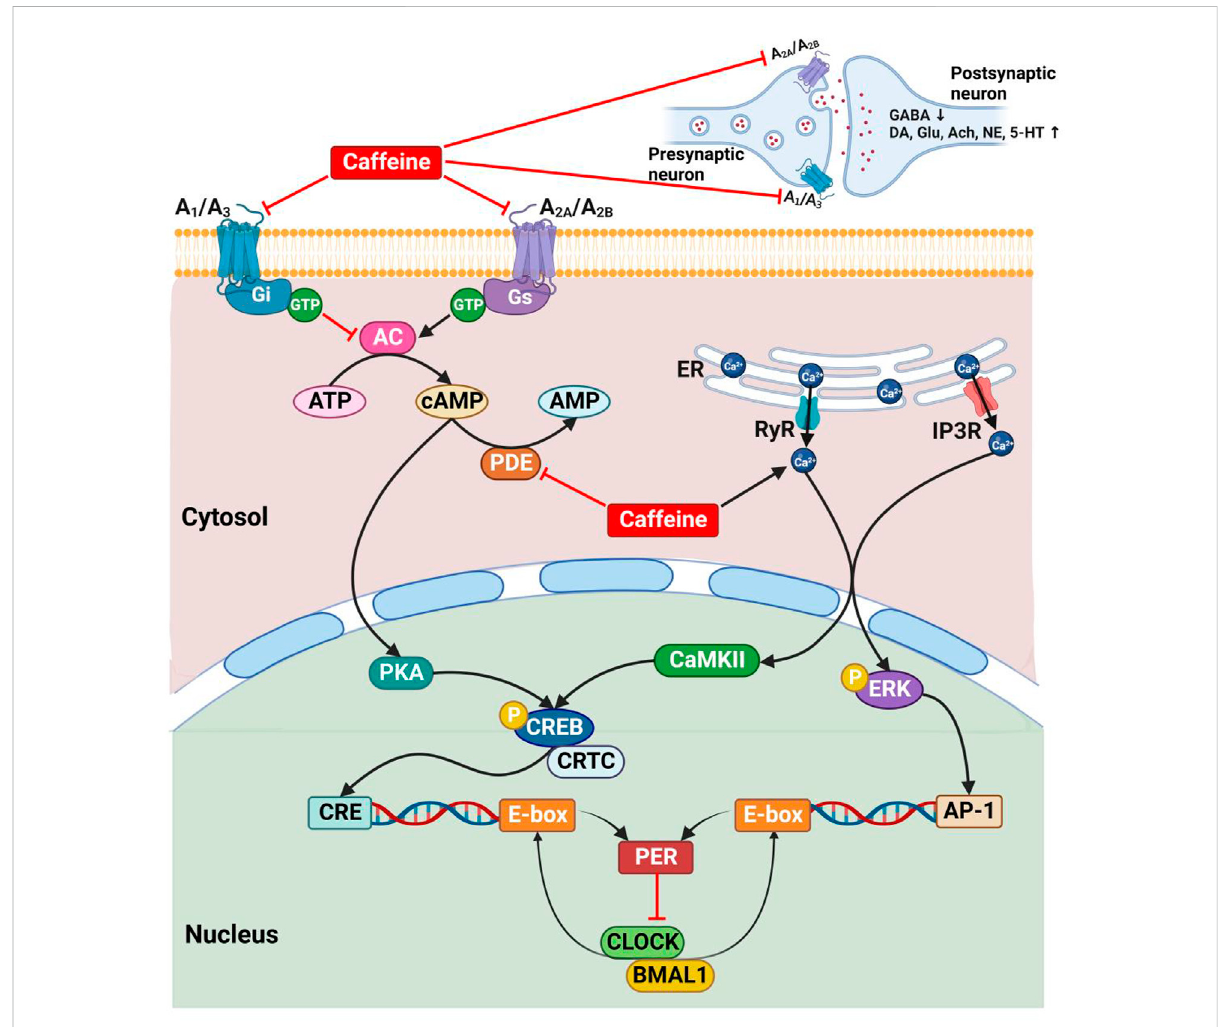
FIGURE 3 The mechanisms of caffeine on circadian rhythms. A 1 , A 3 , A 2A , and A 2B , adenosine receptors; AC, adenylate cyclase; Ach, acetylcholine; AMP, adenosine monophosphate; ATP, adenosine triphosphate; AP-1, activator protein 1; BMAL1, brain and muscle ARNT-like 1; CaMK Ⅱ , Ca 2+ / calmodulin-dependent protein kinase Ⅱ ; cAMP, cyclic adenosine monophosphate; CLOCK, circadian locomotor output cycles kaput; CRE, cAMP response element; CREB, cAMP responsive element binding protein; CRTC, CREB regulated transcription coactivator; DA, dopamine; ER, endoplasmic reticulum; ERK, extracellular regulated protein kinases; GABA, γ -aminobutyric acid; Gi, inhibitory adenylate cyclase G protein; Glu, glutamate; Gs, stimulating adenylate cyclase G protein; GTP, guanosine triphosphate; IP3R, inositol triphosphate receptor; NE, norepinephrine; P, phosphorylation; PDE, phosphodiesterase; PER, period; PKA, protein kinase A; RyR, ryanodine receptor; 5-HT,